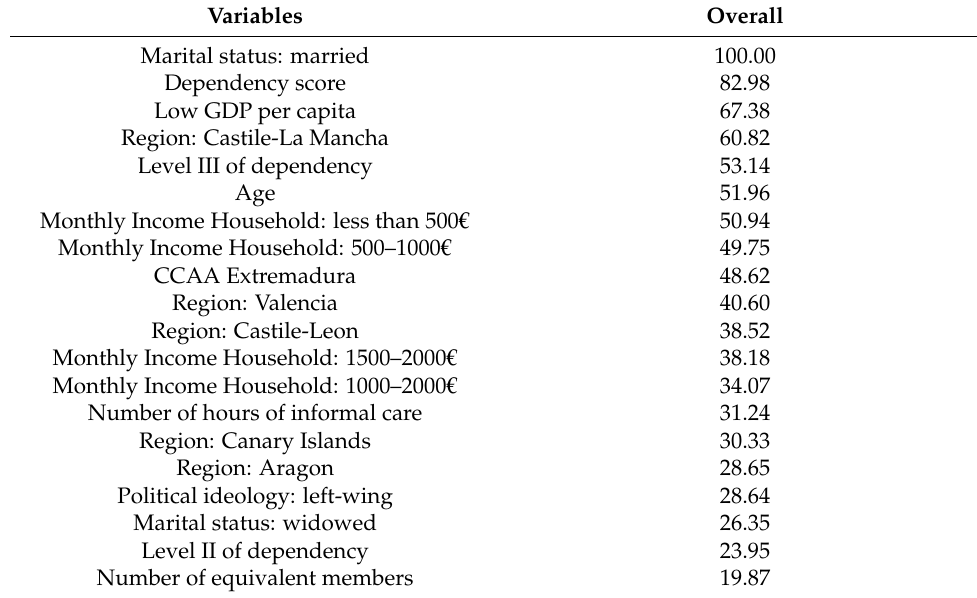
Table 6. Importance of variables in Random